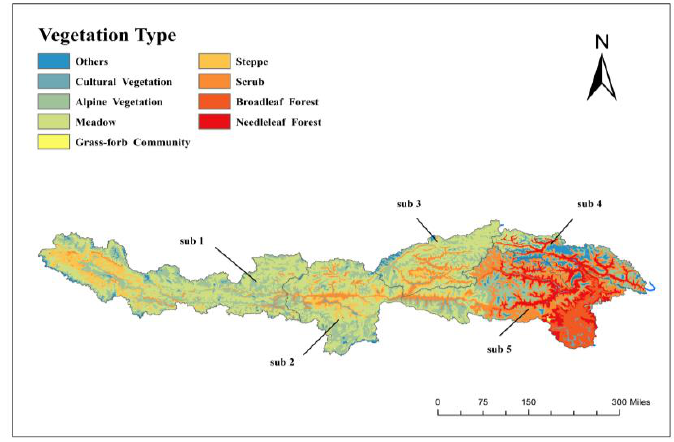
Figure 2. Vegetation conditions map of the YZRB.